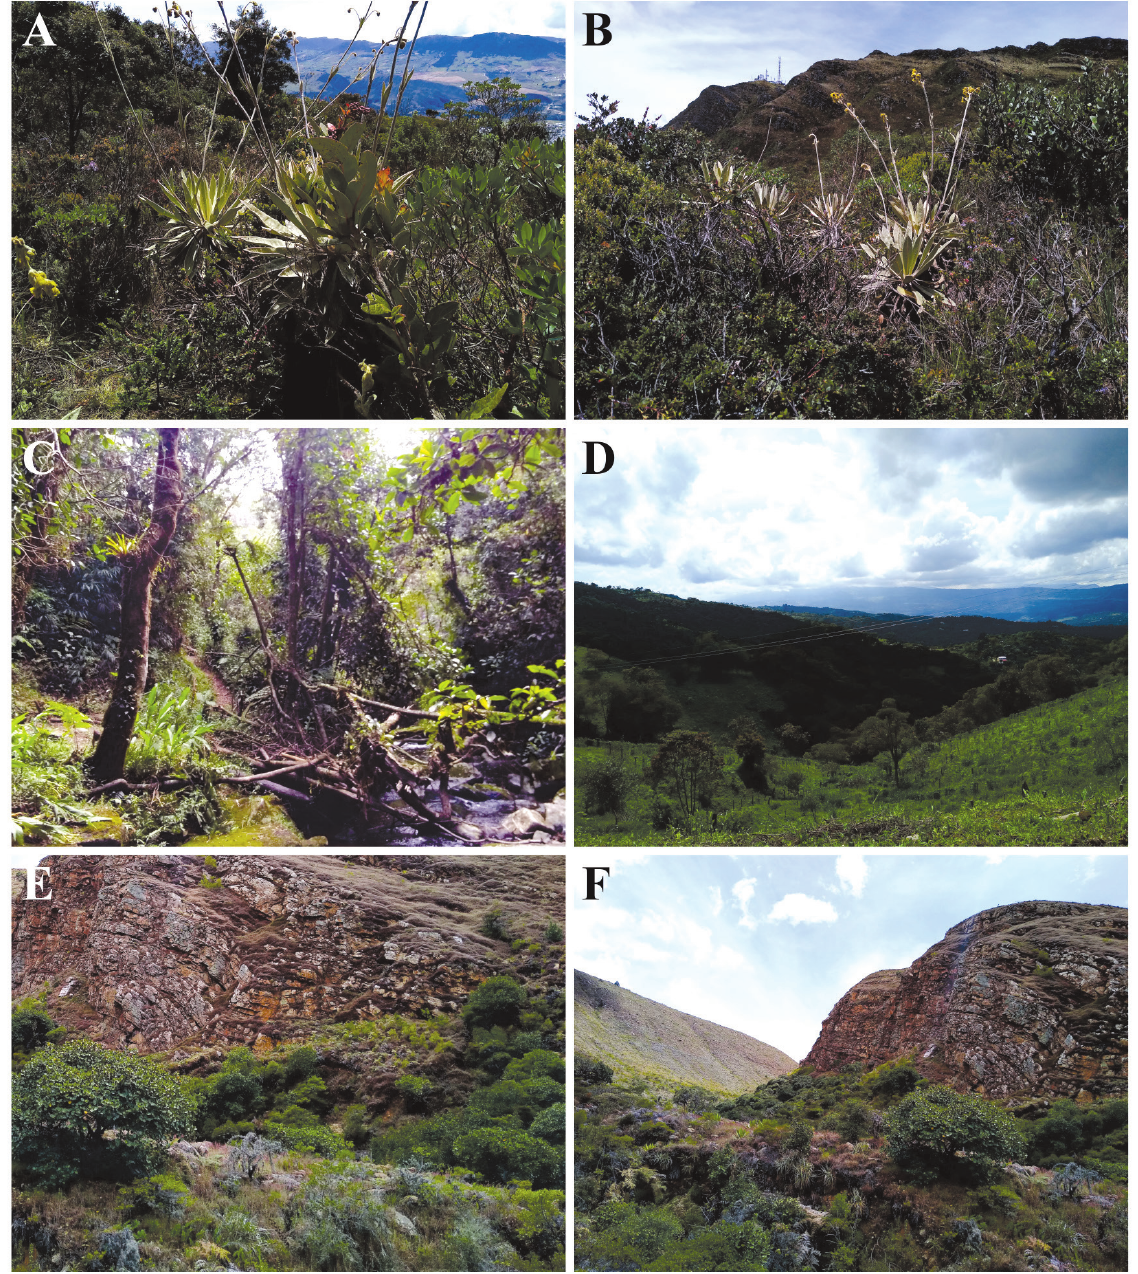
Fig. 8. Habitats of Colombian species of Medionops Sánchez-Ruiz & Brescovit, 2017. A–B .